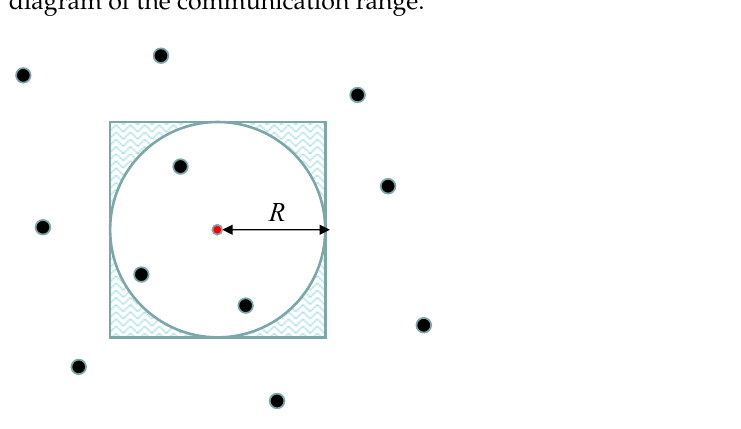
Figure 5. Schematic diagram of the communication range.